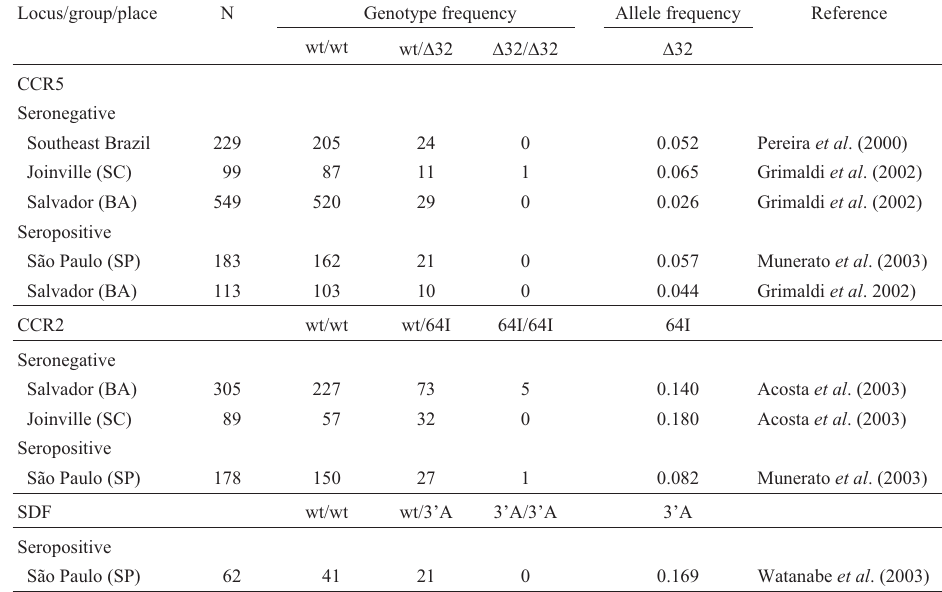
Table 2 - Allele and genotype frequencies of CCR5, CCR2 and SDF-1 loci in Human Immunodeficiency Virus (HIV) seropositive and seronegative Brazilians. Locus/group/place N Genotype frequency Allele frequency